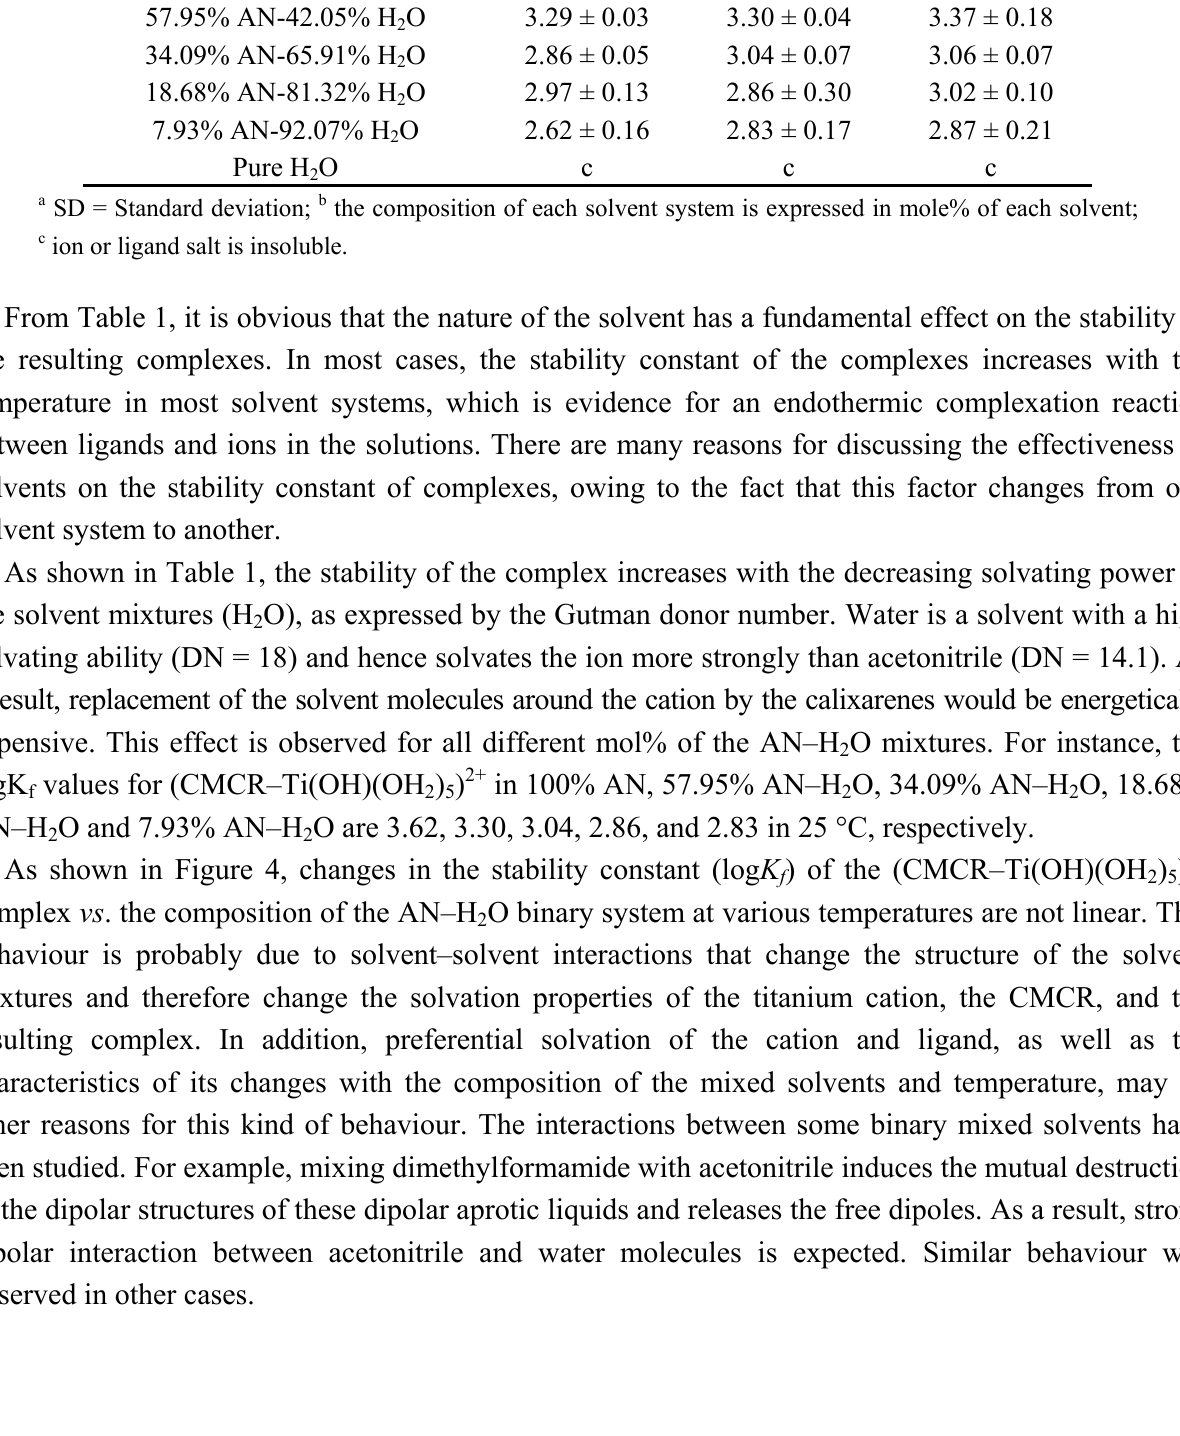
) 52+ complexes in AN–H 2